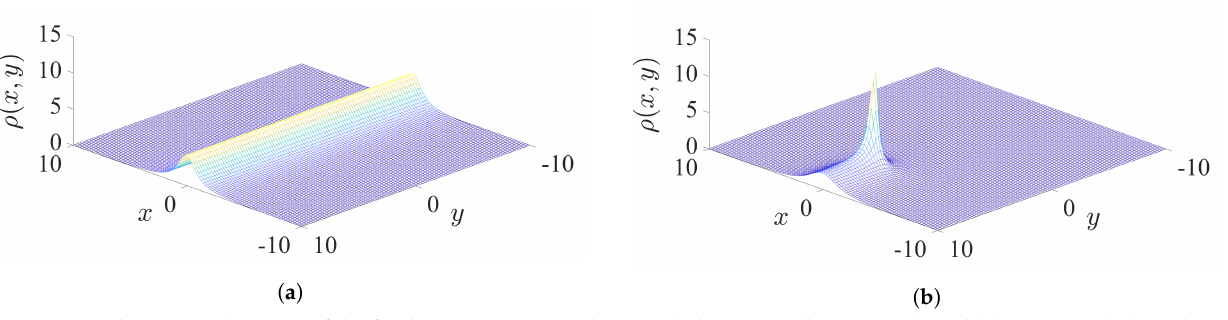
Figure 3. The energy densities of the final states, corresponding to ( a ) domain wall (Figure 1c), and ( b ) string with the ridge formation (Figure 2c).